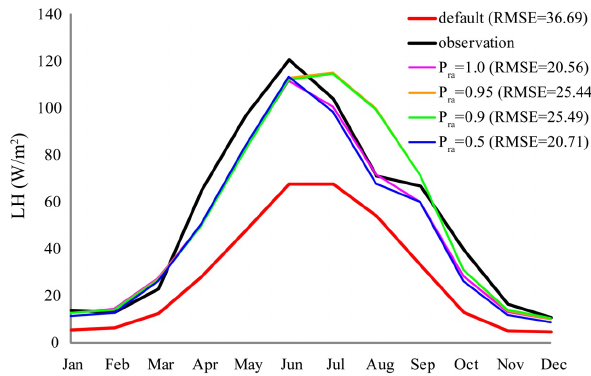
Figure 4. Simulated heat fluxes using the posterior estimates of parameters at the US-MOz site. 808 Fig. 4. Simulated heat fluxes using the posterior estimates of param- eters at the US-MOz